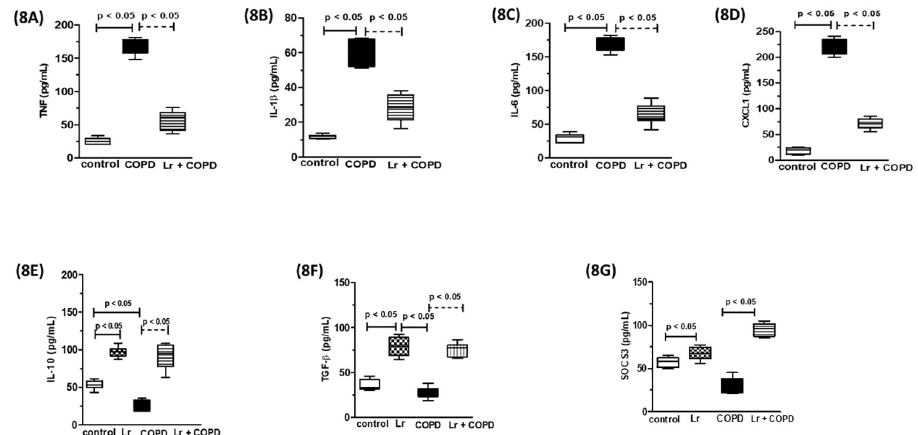
Fig 8. Murine bronchial epithelial cells. Cytokines and chemokines secretion from murine bronchial epithelial cells of control and COPD groups and treated with Lr 1 hour before addition of CSE is illustrated in Fig 8. The inflammatory mediator’s TNF (8A), IL-1 β (8B), IL-6 (8C), CXCL1 (8D), IL-10 (8E), TGF- β (8F) and SOCS3 (8G) in supernatant of murine bronchial epithelial cells were assayed by enzyme-linked immunosorbent assay (ELISA). The assays were performed in triplicate. Results were considered significant when p < 0.05.